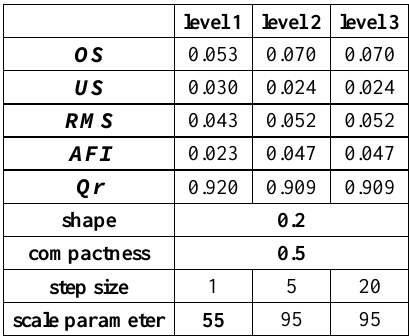
Table 4. Evaluation of segmentation results using